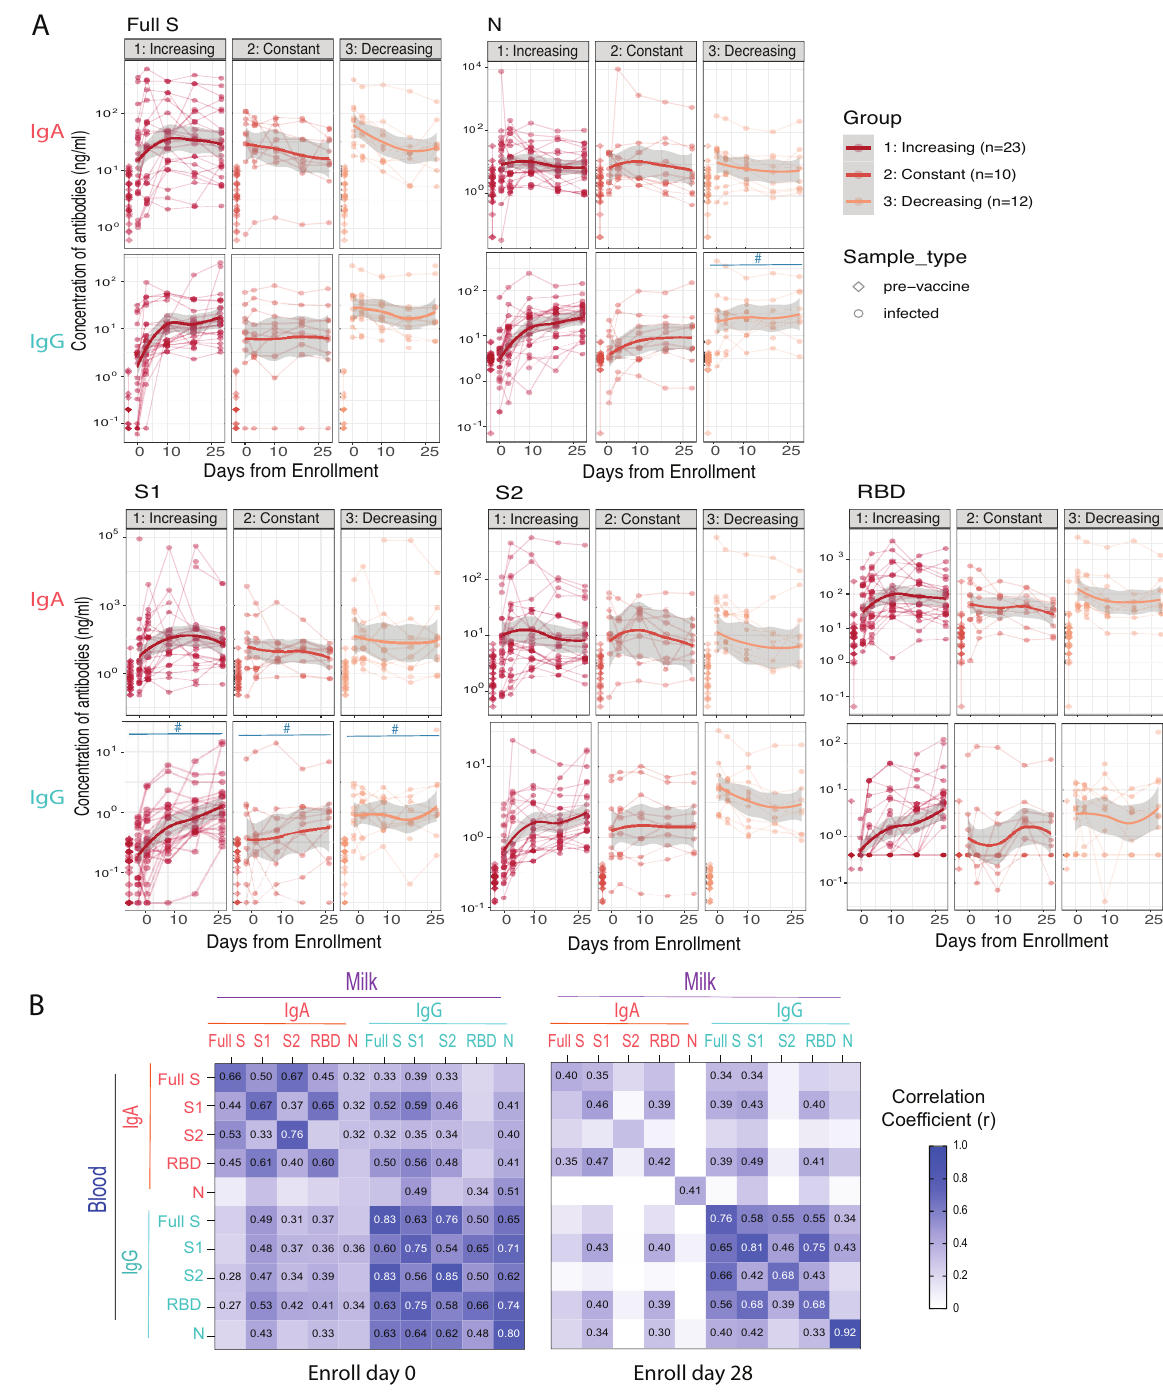
Figure 3. Anti-SARS-CoV-2 IgG and IgA antibody responses in human milk after SARS-CoV-2 infection. The infection cohort was separated into Increasing, Constant or Decreasing groups based on milk IgG antibody level ratios of D28/D0: Increasing with > 1; Constant with 0.8–1.2; Decreasing with ratios < 0.8. ( A ) The milk SARS-CoV-2 specific IgA and IgG antibody levels against full S and N proteins, and S1, S2 and RBD subunits, pre-vaccination and after infection. The antibody levels at all time points post-infection in all groups are significantly higher than that of pre-vaccination controls ( p < 0.0001) and against all antigens and all group. ( B ) Heatmap of Spearman correlation of milk IgA and IgG antibody levels with blood IgA and IgG antibody levels. Correlation coefficients are color coded as shown in the figure and numerical values are shown when correlation p -values <